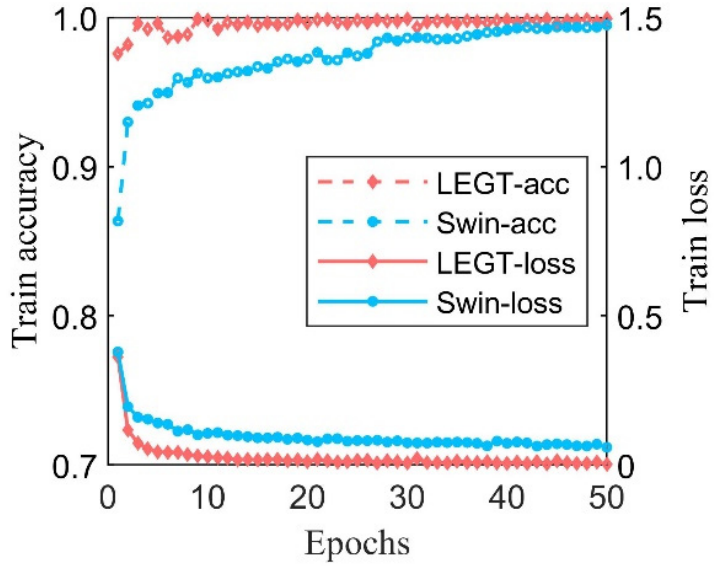
Figure 14. The training process with using LEGT and Swin.